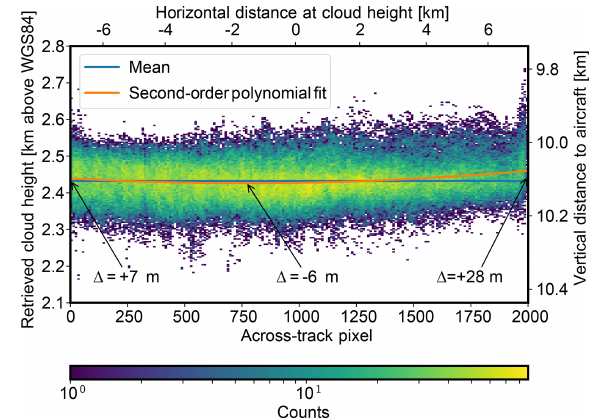
Figure 5. In the time from 09:01:25 to 09:09:00UTC during NAWDEX flight RF11 on 14 October 2016, a stratiform cloud deck was observed. The parabolic fit shows that a small systematic vari- ation can be found beneath the noise (which is due to small-scale cloud height variations and measurement uncertainties). Compared to the overall dimensions of the observed cloud ( ≈ 14km) and the uncertainty of the method, these variations are small. It may still be noted that data from the edges of the sensor ( ≈ 50px on each side) should be taken with